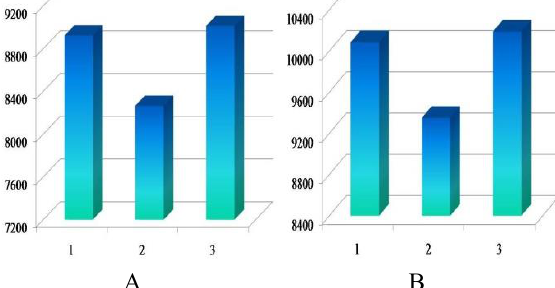
Fig.1. Comparative data regarding daily sums of energy in 3 cases: changing excitation coefficient (tracking) ( c var ) (a), averaged coefficient c selected optimally for a specific interval (b), energy gained from PV conversion (c). Clarifications: time - 1.06, spatial orientation of the battery : angle of inclination to the ground  = 13  , azimuth angle  = 2  , T =25  C, for case A: PV AEG PQ 40/50 batter, for case B : PV Siemens 50 battery.